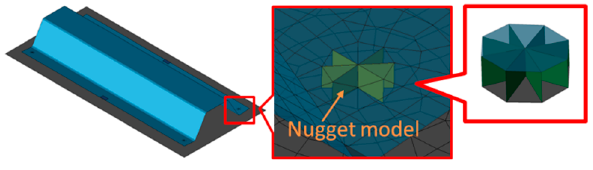
Figure 8. Single spot specimen and measuring points. 5. Application Example 5.1. Single Spot Weld and Identification of the Inherent Deformation A single spot weld was conducted to obtain the inherent deformation data. The test specimen and the measuring points of its deformation are shown in Figure 8, and its ma- terials are shown in Table 1. The materials used for the test specimen were the same as those used for vehicle parts, aide from the fact that the upper part was not plated. In order to identify the deformation of a single spot weld, the welded shape was measured by the geometry-measuring device, Keyence VR5200, before and after welding. The data used for the identification of the inherent deformation was prepared by ex- tracting the deformation from the scanned geometry at the measuring points shown in Figure 8. The FE model for the identification of inherent deformation and its evaluation points are shown in Figure 9. The points highlighted in orange correspond to the measur- ing points that are placed in the same position as the test specimen, shown in Figure 8, and the inherent deformations 𝑆 (cid:3045)(cid:3040) , 𝑆 (cid:3047)(cid:3040) , and 𝑅 (cid:3045)(cid:3040) at these points were evaluated to iden- tify the magnitude of inherent deformations. For 𝑆 (cid:3045)(cid:3040) and 𝑅 (cid:3045)(cid:3040) , the evaluation values for two directions are calculated for the upper and lower plates, respectively. Table 1. Spec of components for vehicle parts.